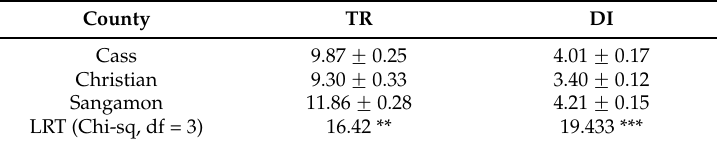
Table 6. Average ± se taxonomic richness (TR) and diversity index (DI) per sample in 2011 and 2012. LRT based on complete model (Table S7c,d); *** p < 0.001.